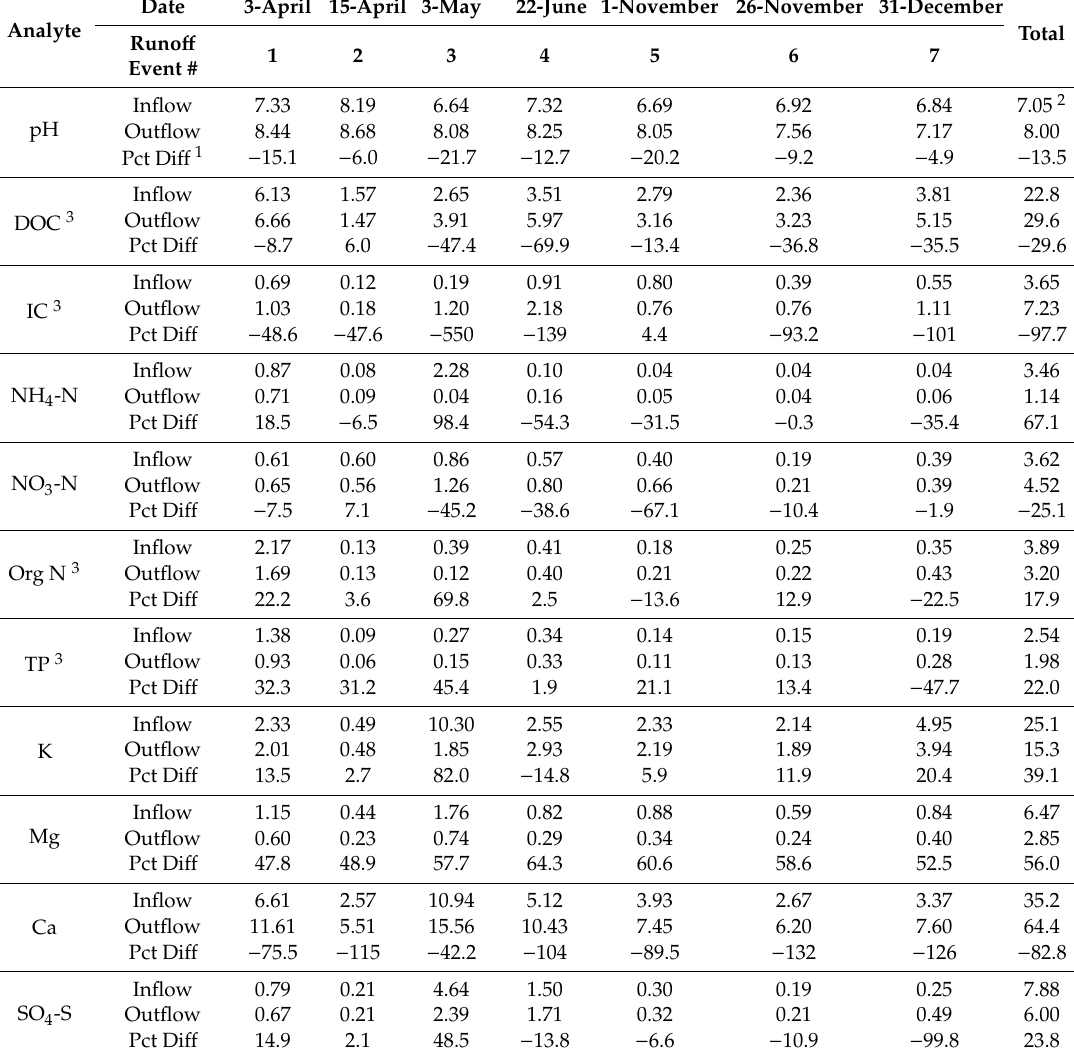
Table 5. Event and cumulative loads (in kg) in the inflow and outflow of the blind inlet for each runo ff